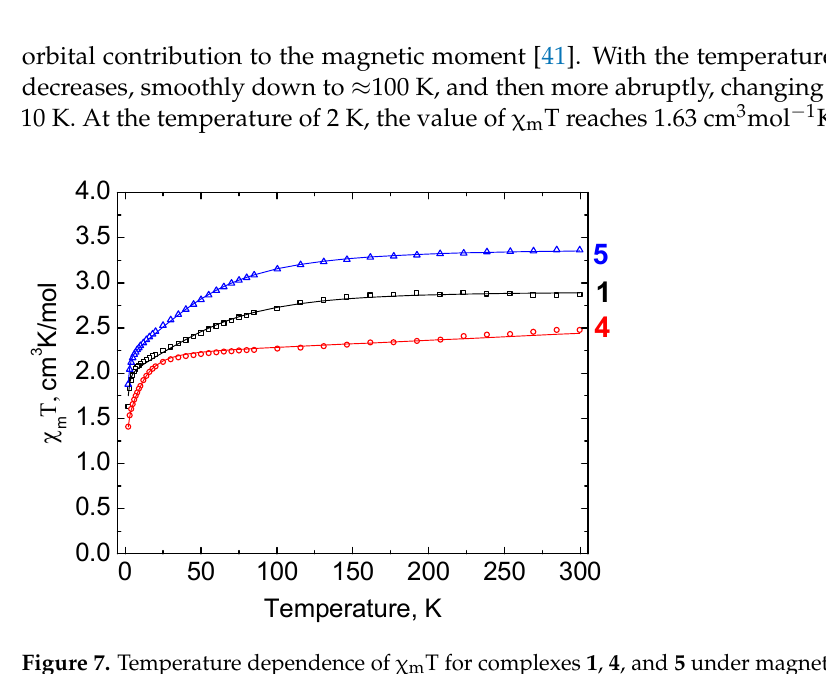
Figure 7 . Temperature dependence of χ m T for complexes 1 , 4 , and 5 under magnetic field of 5000 Oe . Solid lines represent the approximation by PHI software [42].